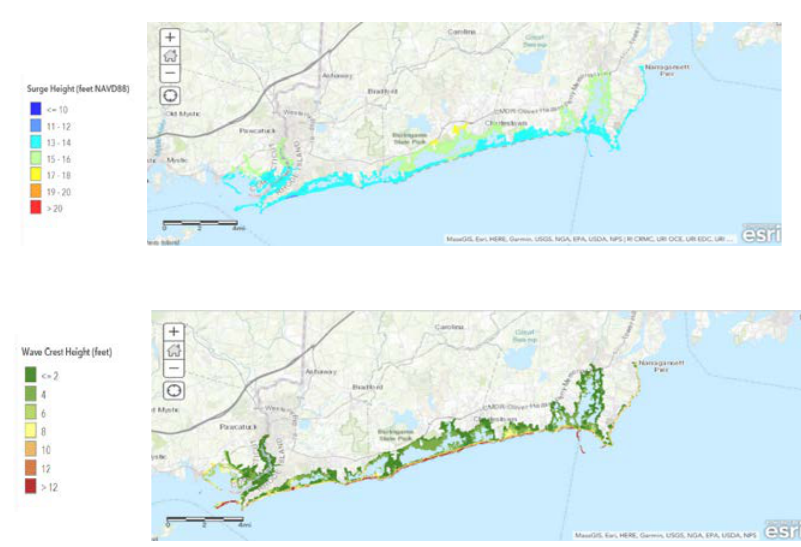
Figure 7. Surge inundation levels (relative to NAVD88) (upper panel) and the wave crest height (lower panel) for southern coast of RI for 100-yr, no-SLR case.